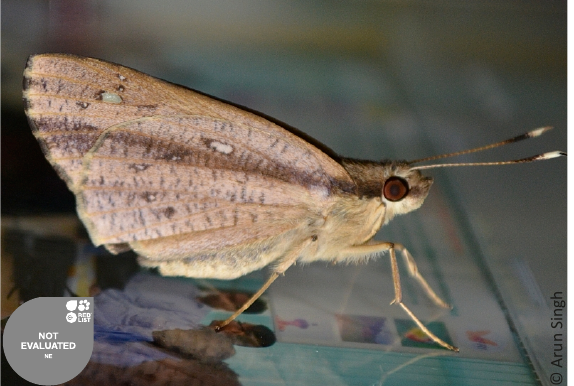
Image 2. Veined Palmer Hidari bhawani (upperside; male; 26.iii.2014-RFRI coll.)